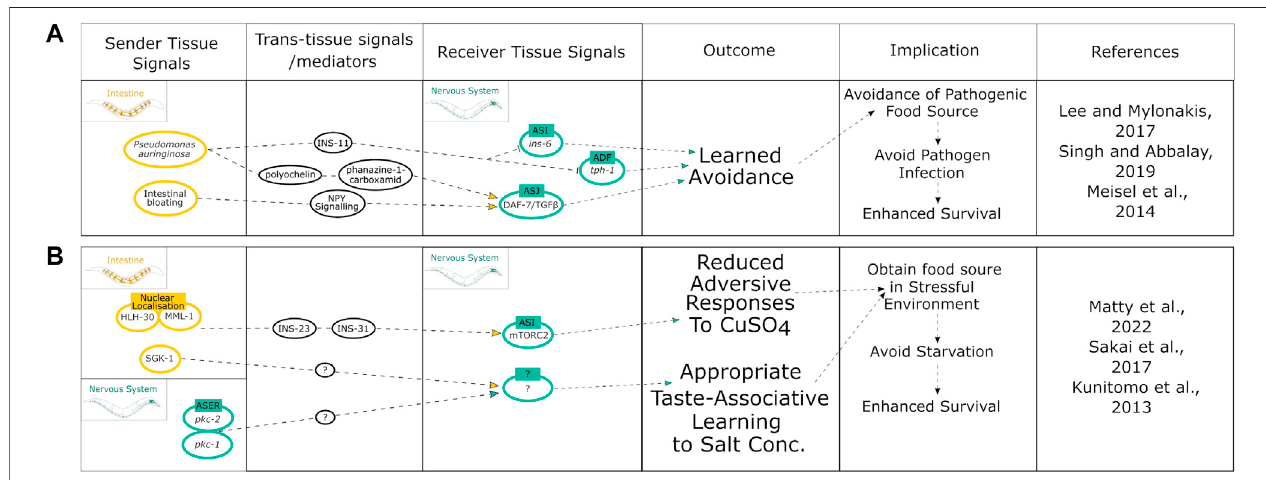
FIGURE3 | Summary ofintestinal modulation ofbehavioralresponseslinked toimproved stress-associated survival. (A) Mechanisms initiated bythe intestine that modulatebehavioruponpathogeninfectiontopromotesurvival. (B) Integrationofbothneuronalandintestinalcuestopursuefoodcuesbydownregulatingavoidanceof risk stimuli to promote